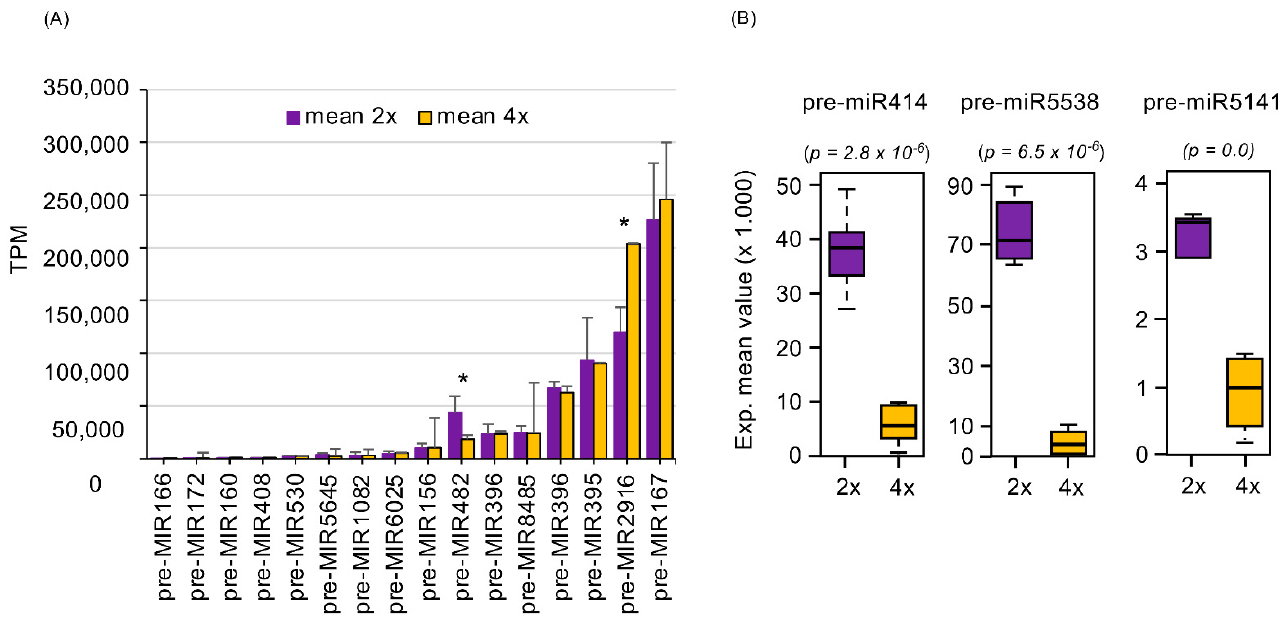
Figure 1. Expression profile of common pre-miRNAs identified in our study ( A ). Values are expressed in transcript per million (TPM) and as the mean of 2x (purple) and 4x (orange) genotypes. Standard error values are also reported. Box plot of expression mean value was calculated as transcript per million (TPM) of pre-miR414, pre-miR5538, and pre-miR5141 ( B ). Significant statistical differences (p < 0.05) are marked with asterisk.